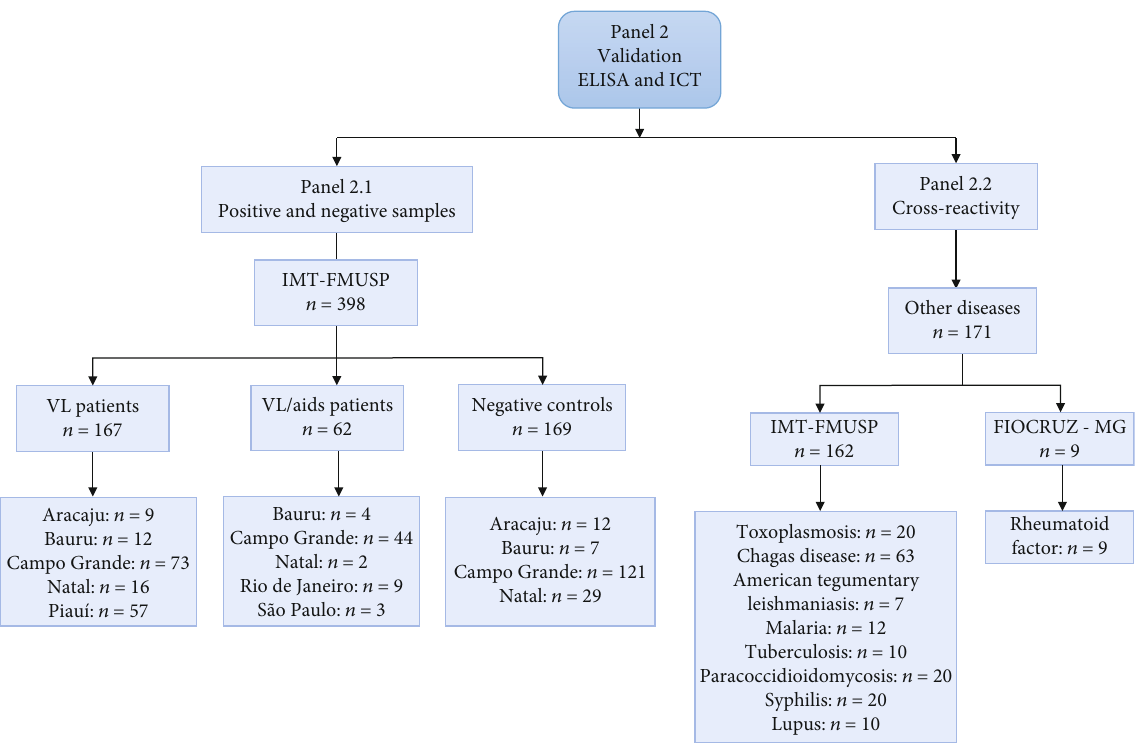
Figure 2: Sera samples used to validate the ELISA and ICT kits and the origin of the samples (panel 2.1 and panel 2.2). n : number of samples; VL: visceral leishmaniasis; VL/AIDS: coinfected patients; FIOCRUZ-MG: René Rachou Institute (FIOCRUZ, Minas Gerais State); IMT-